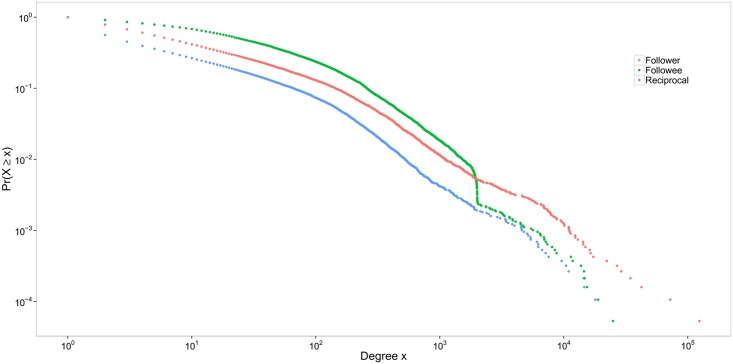
Degree distribution in the follower-followee network.Log-log plot of the complementary cumulative distribution functions of the number of followers, the number of followees, and the number of reciprocal friends. The number of followers and followees for each user were obtained from the user profile API, therefore, are not constrained by the privacy setting for obtaining following relationships.